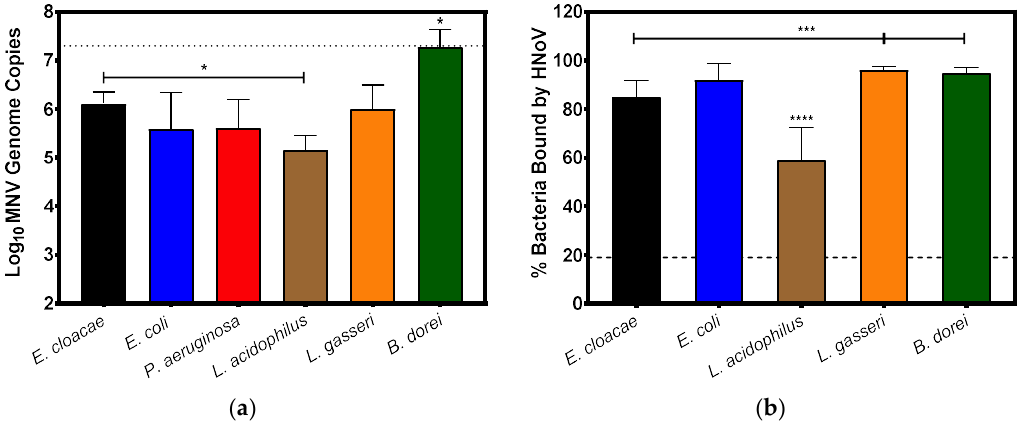
Figure 2. Noroviruses attach to select commensal bacteria after one hour of incubation. ( a ) MNV-1 (10 7 TCID50/mL) was used to inoculate diluted bacterial cultures which were incubated at 37 °C for 1 h. Viral attachment was quantified using RT-PCR. MNV-1 genomes were detected in all bacterial cultures and levels of detection in B. dorei samples were significantly higher ( p ≤ 0.01) than all other bacteria. Detection of MNV in L. acidophilus samples was only significantly lower than E. cloacae (* = p = 0.03). Dashed line indicates average amount of input virus. ( b ) HNoV VLPs (10 µg) were added to diluted bacterial cultures and incubated at 37 °C for 1 h. VLP attachment was measured using flow cytometry and percent attachment quantified using Overton Subtraction compared to isotype controls. The percent of L. acidophilus bacteria bound by the VLPs was significantly less (**** = p < 0.0001) than all other bacteria tested. Binding of E. cloacae populations was also significantly lower than binding to either L. gasseri or B. dorei (*** = p ≤ 0.005). Dashed line denotes limit of detection of the assay. ( n = 3 for all attachment assays). Statistical analysis was performed using an unpaired Student’s t test in GraphPad Prism. Attachment assays using HNoV GII.4 VLPs were performed using the commensal bacteria to compare binding trends between human and murine noroviruses. P. aeruginosa was excluded from the analysis of HNoV attachment due to technical issues with the flow cytometry read-out using this bacterium. Similar to what has been previously observed with HNoV positive stool samples [24], HNoV VLPs were capable of binding to a wide variety of commensal bacteria (Figure 2b). No significant differences in HNoV binding were observed between the Proteobacteria species ( E. coli and E. cloacae ); however, HNoV-bound E. cloacae significantly less compared to either L. gasseri or B. dorei ( p < 0.005). The input particle ratios and methods of analysis are different between MNV and HNoV VLPs and thus absolute quantities of binding cannot be compared. However, the trends of viral attachment to the panel of bacteria do show some commonalities. As with MNV, we observed the lowest frequency of HNoV binding to L. acidophilus populations and binding to this bacterium was significantly lower ( p < 0.0001) than binding to any of the other bacteria tested (Figure 2b). Since both viruses bind significantly less to L. acidophilus and relatively high to other bacteria, this suggests that L. acidophilus either lacks or does not express enough of a specific surface structure(s) necessary for high levels of viral attachment. 3.2. Temporal Attachment of Murine Norovirus to Commensal Bacteria All currently published data investigating norovirus attachment to commensal bacteria focuses on a single time point [23,24,26,27], and we questioned whether binding would change with shorter or longer incubation periods. To investigate this, we used RT-q-PCR analysis to quantify MNV binding to our panel of commensal bacteria from 0 to 24 h of incubation. Results showed that MNV binds to all of the bacteria almost immediately, as evidenced by the detection of viral RNA at the 0 h time point (Figure 3). When examining attachment to Proteobacteria, viral attachment to E. cloacae and P. aeruginosa shows slow declines in viral attachment after 0.5 h. Viral attachment to P. aeruginosa do not significantly differ from time 0 h attachment at any point of the tested time points, but